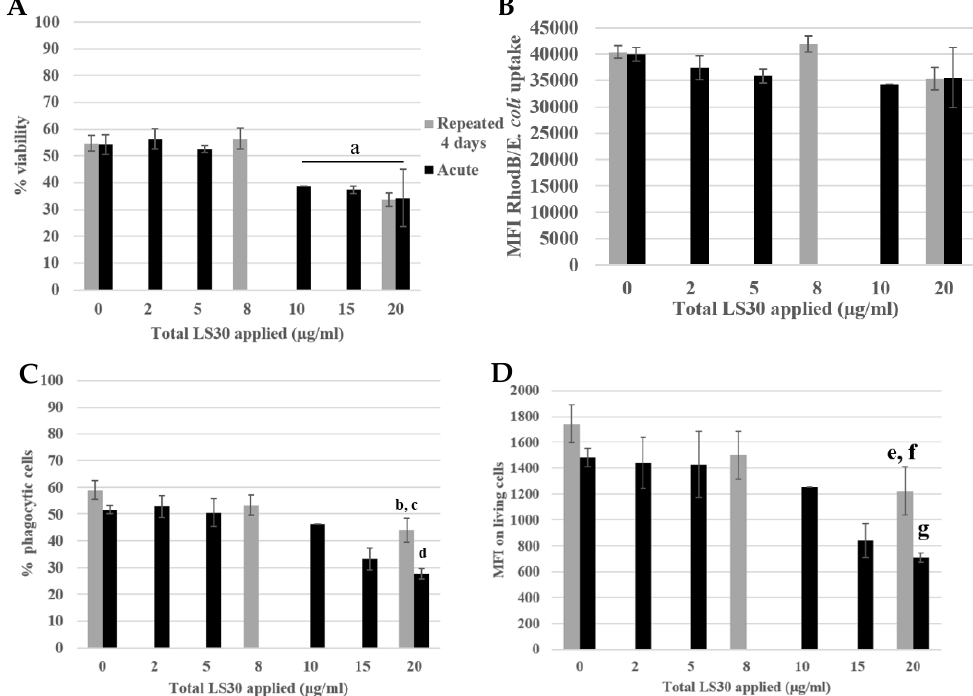
Figure 9. Phagocytosis assay of LS30 exposed cells, stimulated by Escherichia coli. ( A ) Cell viability (a: CTL versus acute 10 µg/mL, 15 µg/mL, acute 20 µg/mL and repeated 5 µg/mL, p value < 0.05). ( B ) Escherichia coli uptake followed by rhodamine B fluorescence. ( C ) Proportion of phagocytic cells (b: CTL versus repeated 5 µg/mL, p -value < 0.05; c: repeated 5 µg/mL versus acute 20 µg/mL, p -value < 0.01; d: CTL versus acute 20 µg/mL, p -value < 0.01). ( D ) Phagocytic activity of the cells (e: CTL versus repeated 5 µg/mL, p -value < 0.05; f: repeated 5 µg/mL versus acute 20 µg/mL, p -value < 0.01; g: CTL versus acute 20 µg/mL, p -value < 0.01.